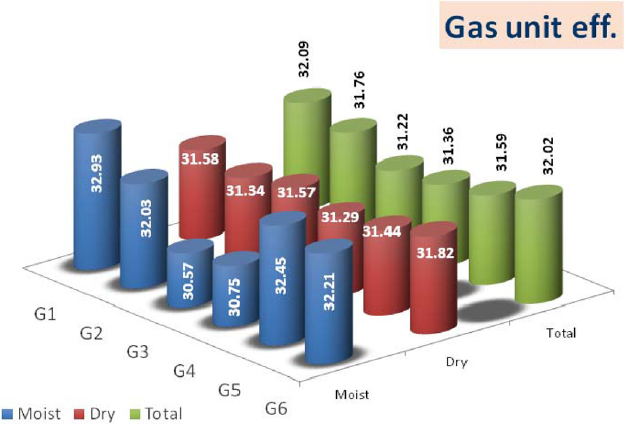
Fig. 8. Gas units ef fi